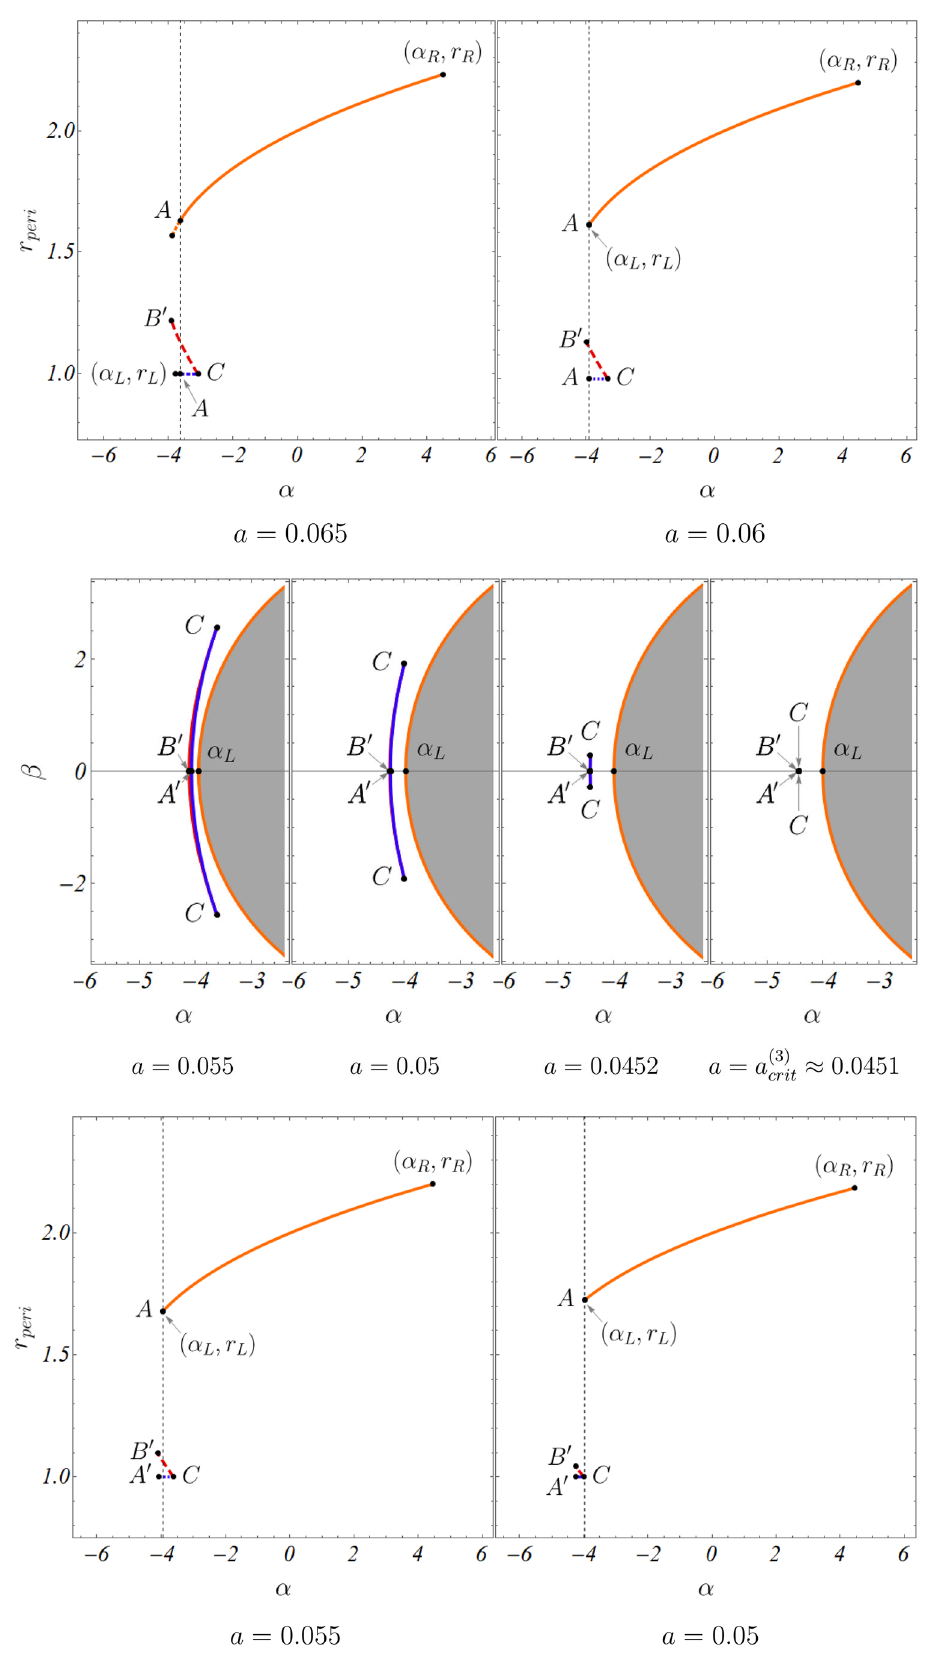
Fig. 10 Dependence of the impact parameter α on the radial distance at the shadow boundary for spin parameter ≈ 0 . 06 ≤ a < a ( 1 ) ≈ 0 . 07. a ( 2 ) crit crit The observer inclination angle is θ = 90 ◦ . The same conventions 0 are used as in Fig. 9. The stable and unstable branches of the spherical orbits associated with the outer light ring get disconnected, and we observe a gap